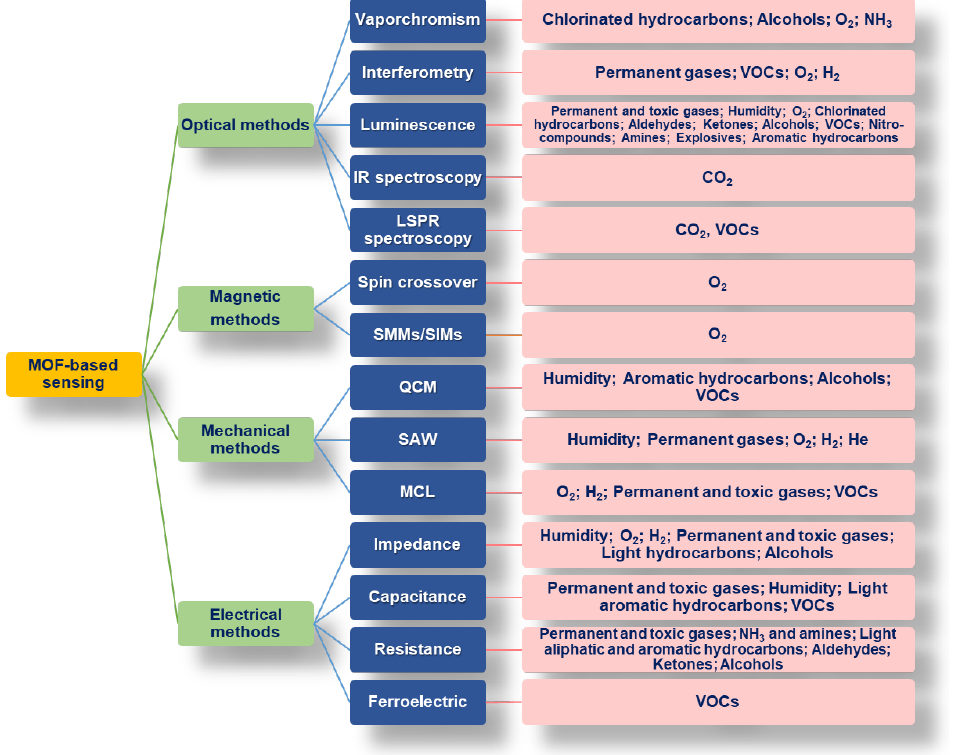
Figure 2. Scheme of the various methods employing MOF materials for chemical sensing.